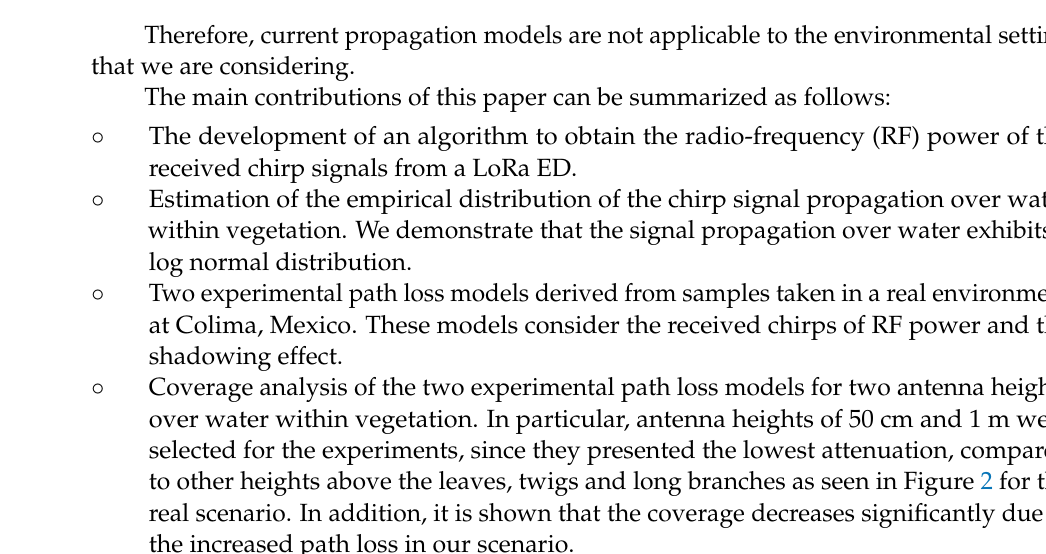
Figure 1. ( a ) Scenario for urban path loss models. ( b ) River environment with large trees.